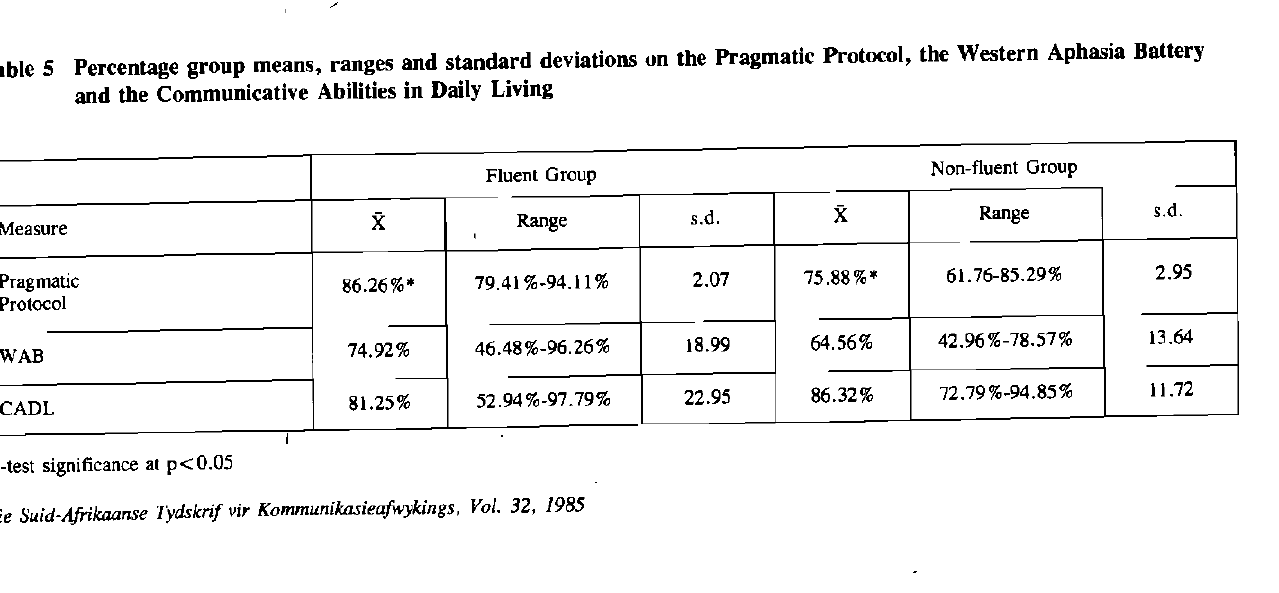
Figure 3 Percentage group means and ranges of appropriate pragmatic behaviour on the Pragmatic Protocol, and correct responses on the Western Aphasia Battery and Communicative Abilities in Daily Living.